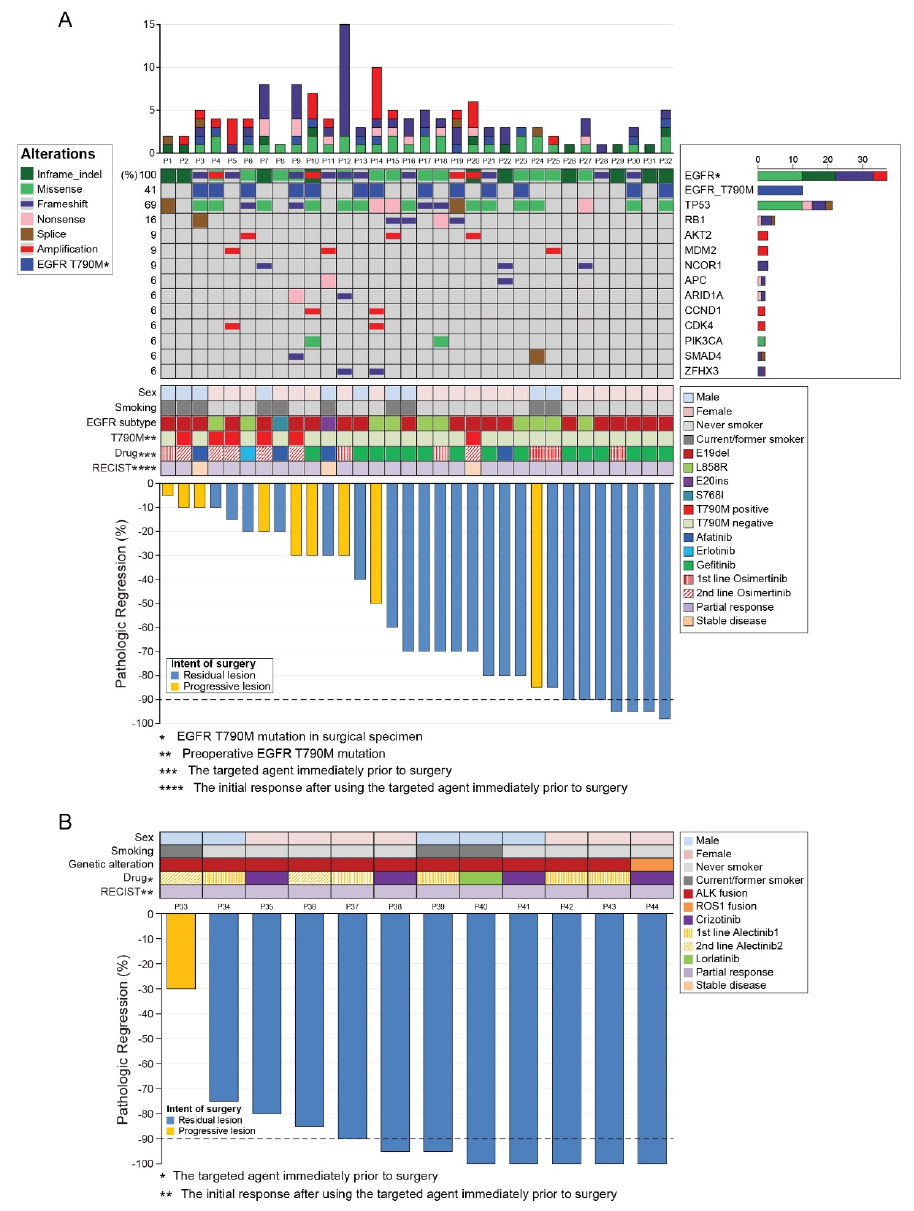
Figure 2. Landscape of mutation profiles and pathological responses at the primary lesion. ( A ) Landscape of mutation profiles analyzed using next-generation sequencing of samples from the 32 patients with EGFR mutations. The X-axis represents individual samples, and the Y-axis represents individual mutated genes. The bar graph on the right shows the mutation frequency of each mutated gene in the 32 samples. The top column represents tumor mutation burden. Different colors and notes at the left represent mutation types. Middle rows indicate sex, smoking status, EGFR mutation subtype, presence of the T790M mutation before surgery, targeted agent immediately before surgery, and best response after using the targeted agent immediately before surgery. The Waterfall chart at the bottom shows the pathologic response at the primary lesion of the 32 patients with EGFR mutations. ( B ) The Waterfall chart shows the pathologic response at the primary lesion of the 12 patients with ALK or ROS1 fusions. Upper rows indicate sex, smoking status, genetic alteration, targeted agent immediately before surgery, and best response after using the targeted agent immediately before surgery. RECIST: Response Evaluation Criteria in Solid